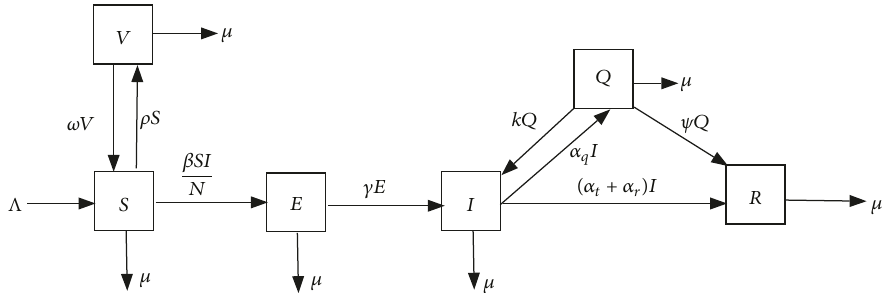
Figure 1: A compartmental model for the transmission dynamics of CBPP with antibiotic treatment and